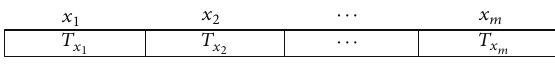
Figure 2: Fuzzy priority vector,